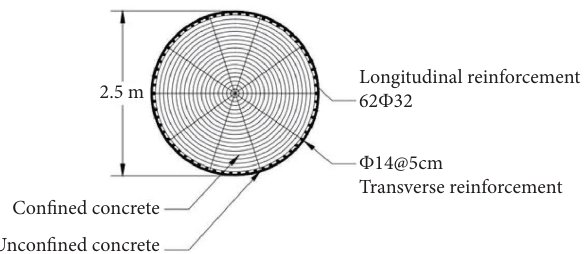
Figure 4: Fiber section simulation of the middle column.